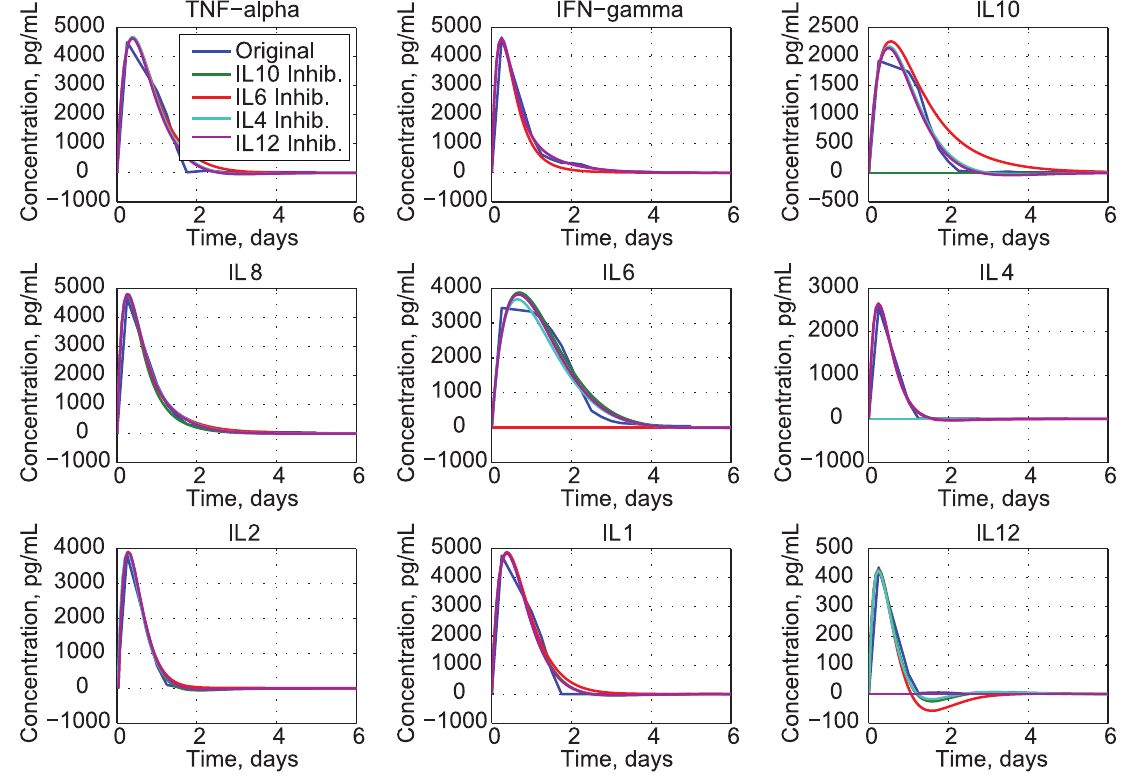
Figure 11. Effects of inhibiting anti- and mixed-inflammatory cytokines.